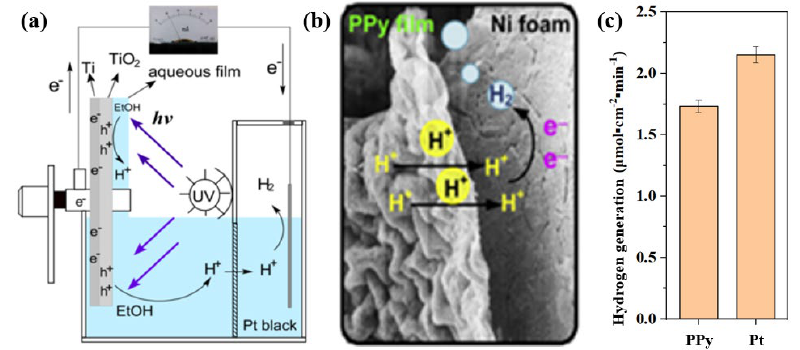
Figure 10. ( a ) Schematic diagram of TiO 2 /Ti-Pt black rotating disk PFC for H 2 evolution (Reprinted/adapted with permission from Ref. [102]. 2015, ELSEVIER.), ( b ) SEM image of PPy cathode (Reprinted/adapted with permission from Ref. [102]. 2016, ELSEVIER.), and ( c ) H 2 generate rates obtained by PPy cathode and Pt cathode in rotating disk PFC.